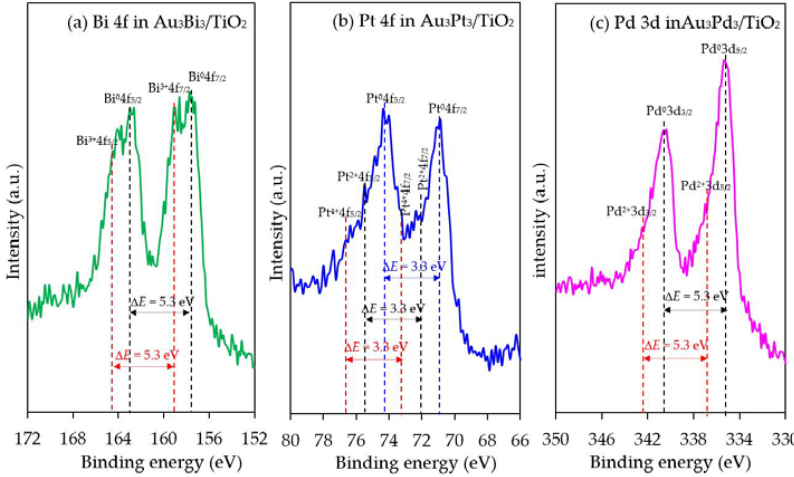
Figure 12. Representative HR-XPS spectra of Bi 4f, Pt 4f and Pd 3d in the respective Au 3 M 3 /TiO 2 photocatalysts.